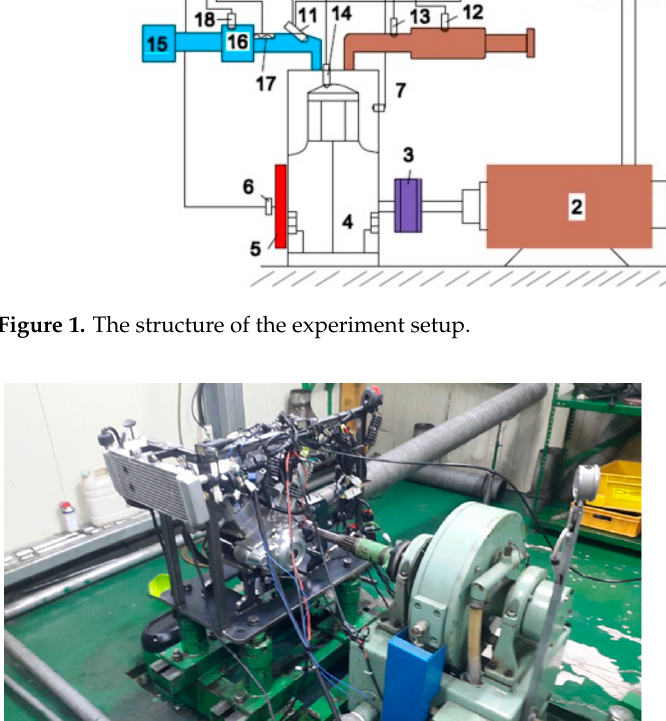
Figure 2. The experiment engine setup system